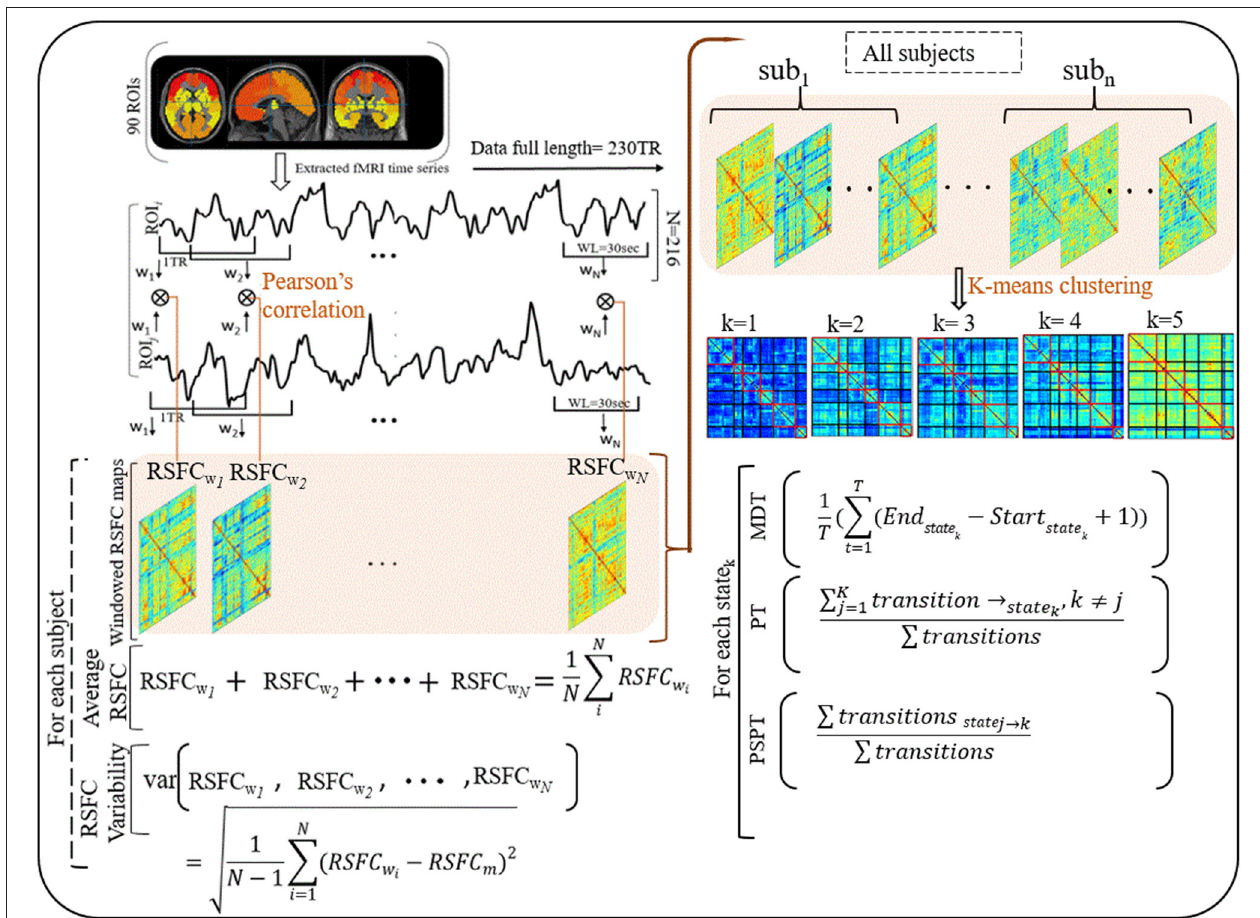
FIGURE 1 | Illustrations of procedures for dynamic RSFC and state analyses. Ninty ROIs’ times series were extracted from fMRI data (230 TR) and sliding windows (WL = 30s) were used to generate dynamic RSFC maps. Dynamic RSFC properties (average dynamic RSFC, and connectivity variability) were computed across windows. Optimal clusters (states, k = 1–5) were generated using K-means clustering. State properties [the mean dwelling time of the state (MDT), and state transitioning (PT, PSPT)] were further estimated from each state. RSFC w i represents dynamic RSFC map at window w i ; MDT and PT denote the mean dwelling and probability of transitioning to state k respectively, whereas PSPT signifies the probability of specific transitioning from state j to state k .